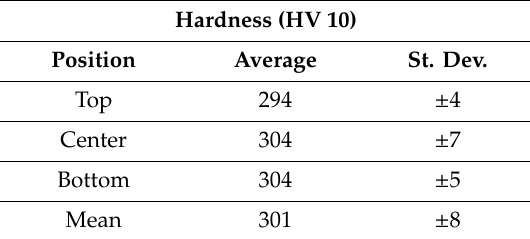
Table 5. Microhardness at di ff erent heights.